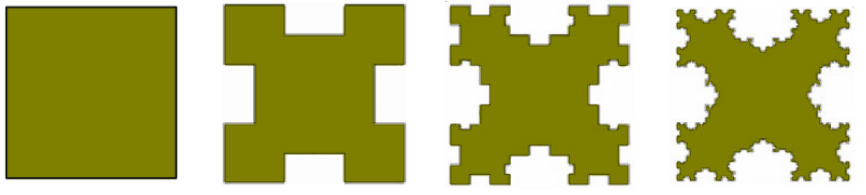
Figure 20. Four stages of the Minkowski